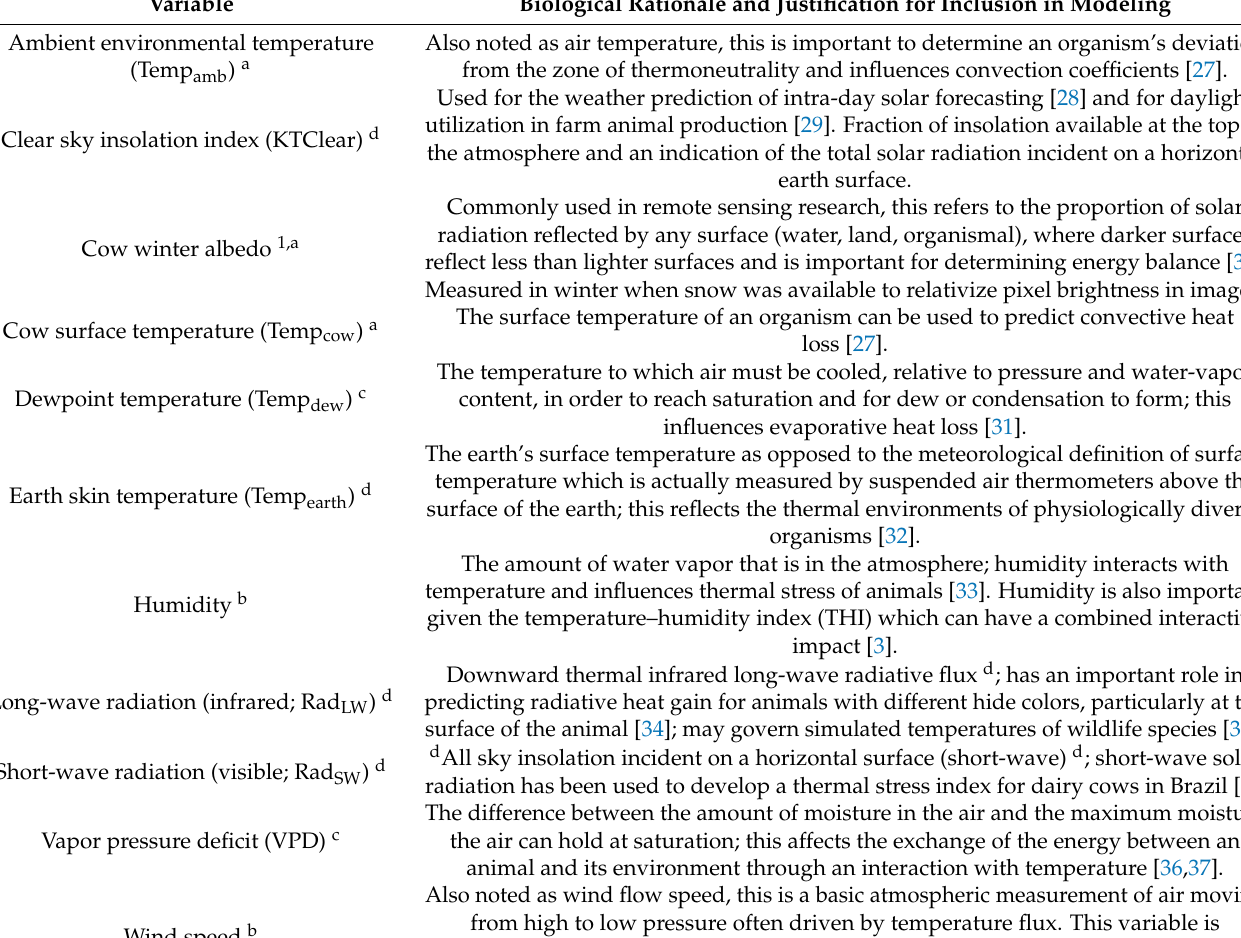
Table 1. Potential predictor variables and associated justification for inclusion for modeling external surface temperatures of red, white, and black hided cattle (Temp cow ) and then the difference ( ∆ T) between Temp cow and the ambient temperature of the surrounding environment (Temp amb ). Variables are listed in alphabetical order. Cattle were white, red, and black Bos taurus cows free roaming on rangeland west of Laramie, WY, USA at the University of Wyoming, Agriculture Experiment Station—Beef